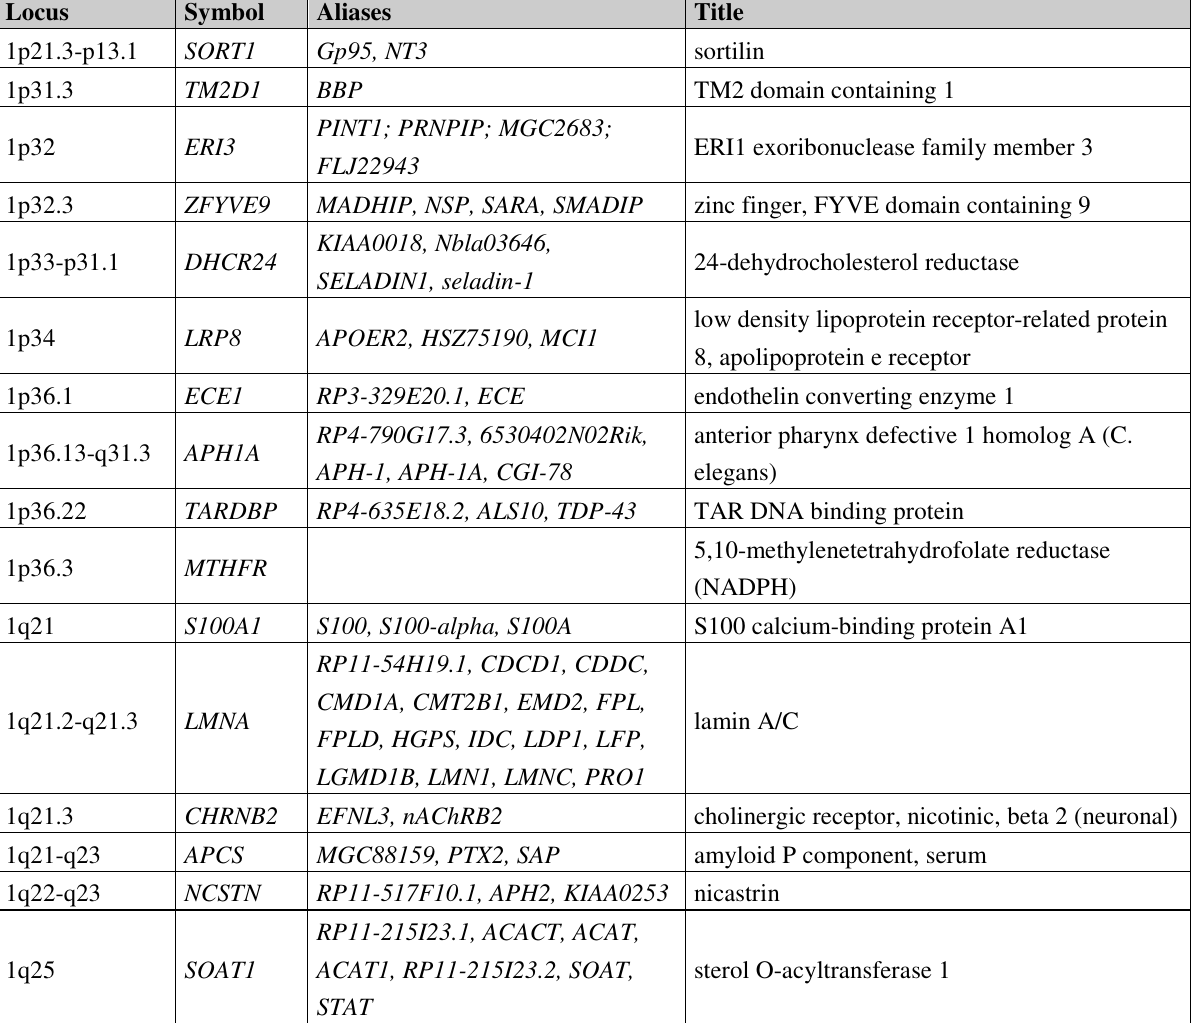
Table 1. Selected human genes investigated as potential candidate genes associated with Locus Symbol